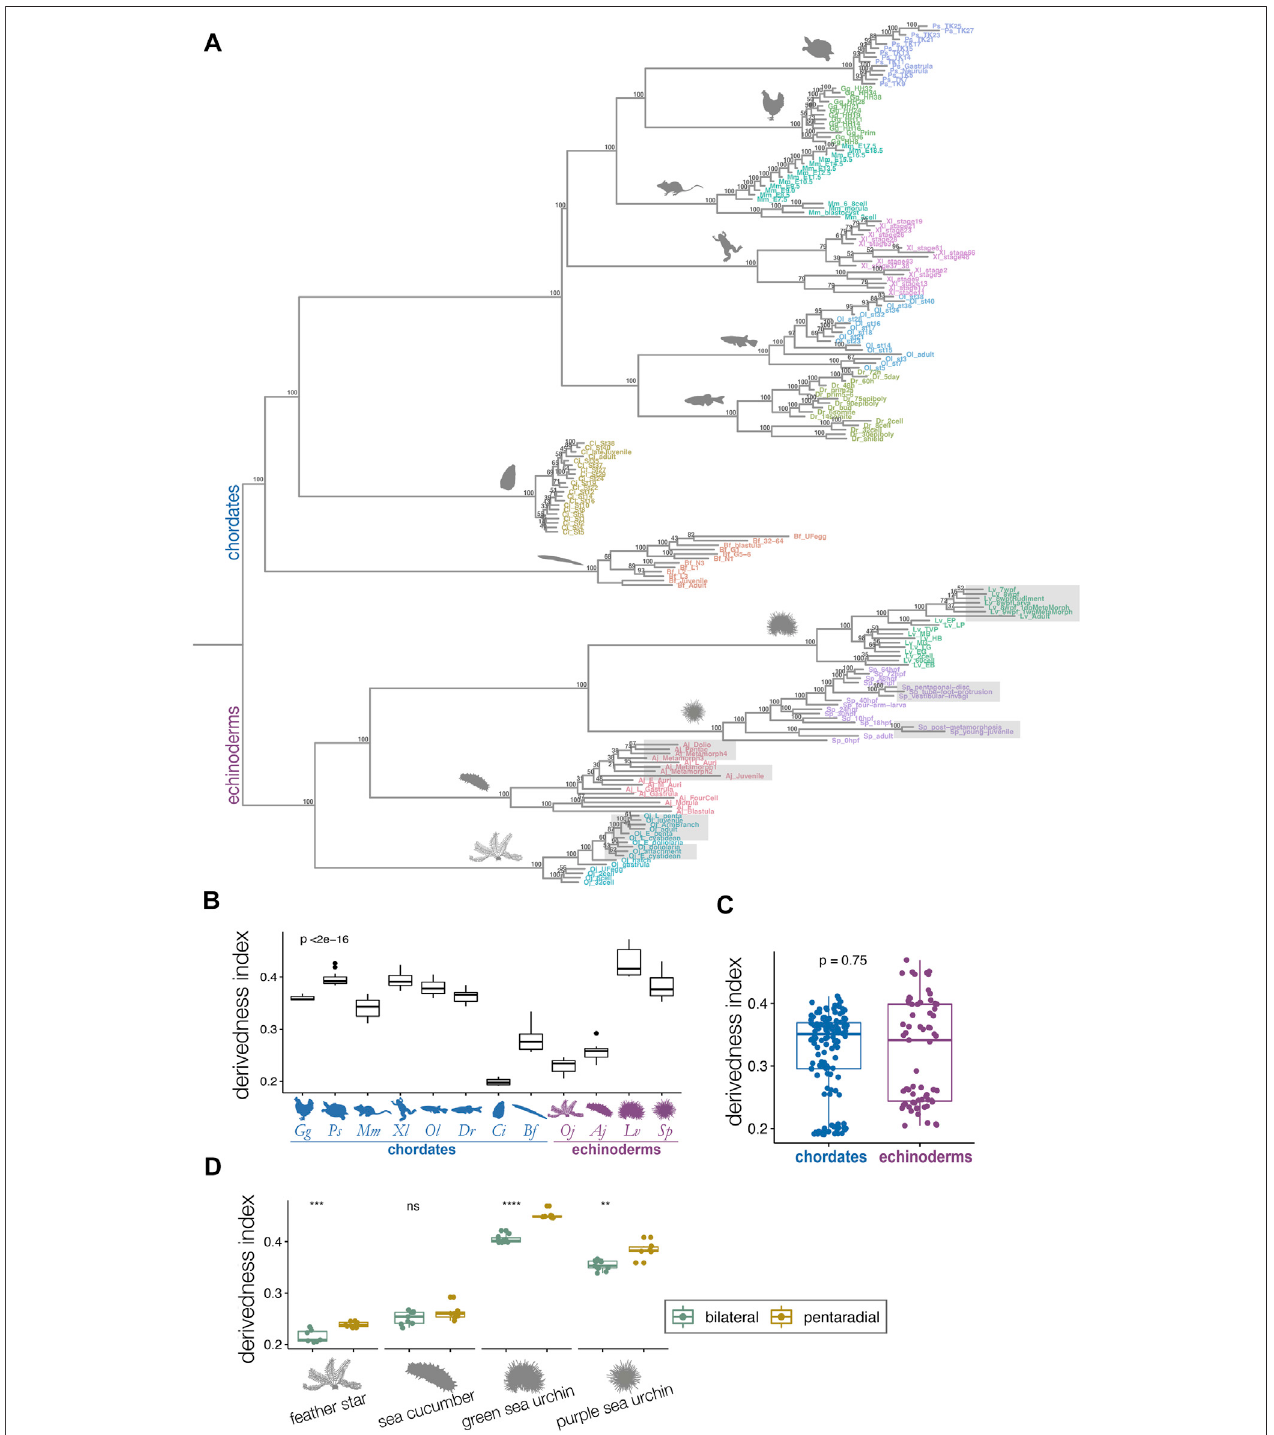
FIGURE 3 | Derivedness tree of developmental stages of echinoderms and chordates based on transcriptomic pro fi les. (A) Tree showing transcriptomic derivednessofchordateandechinodermembryos.Embryosofeachspeciesaredenotedbythesamecolor.Supportvaluesareconsensusfrom100randombiological replicates-included (BRI) trees (see also Methods). Shaded stages in echinoderm species are developmental phases with penta-radial structures. (B) The range of derivednessindicesofembryosforeachspecies.Vertebratespeciesandthetwoseaurchinspecieshavefairlyhighderivednessindiceswhereas C.intestinalis has the lowest (blue: chordate species; purple: echinoderm species; Kruskal-Wallis p < 2e-16) (C) The range of derivedness indices of echinoderm and chordate embryos. Thisshowsthatechinodermsdonotappeartohavemuchhigherderivednessindexthanchordates.(Mann-Whitney p (cid:1) 0.75) (D) Therangeofderivednessindicesofthe